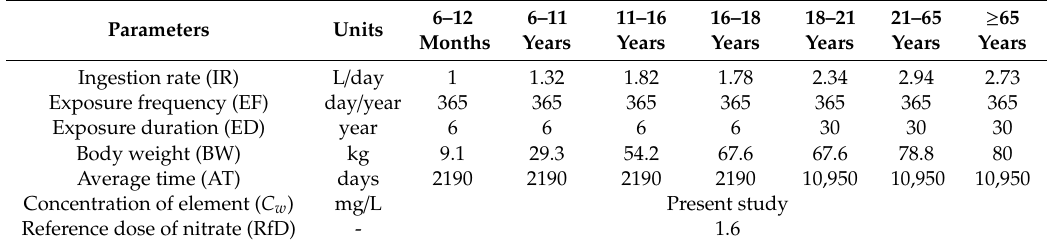
Table 2. Key parameters for computing the exposure risk of nitrate through drinking